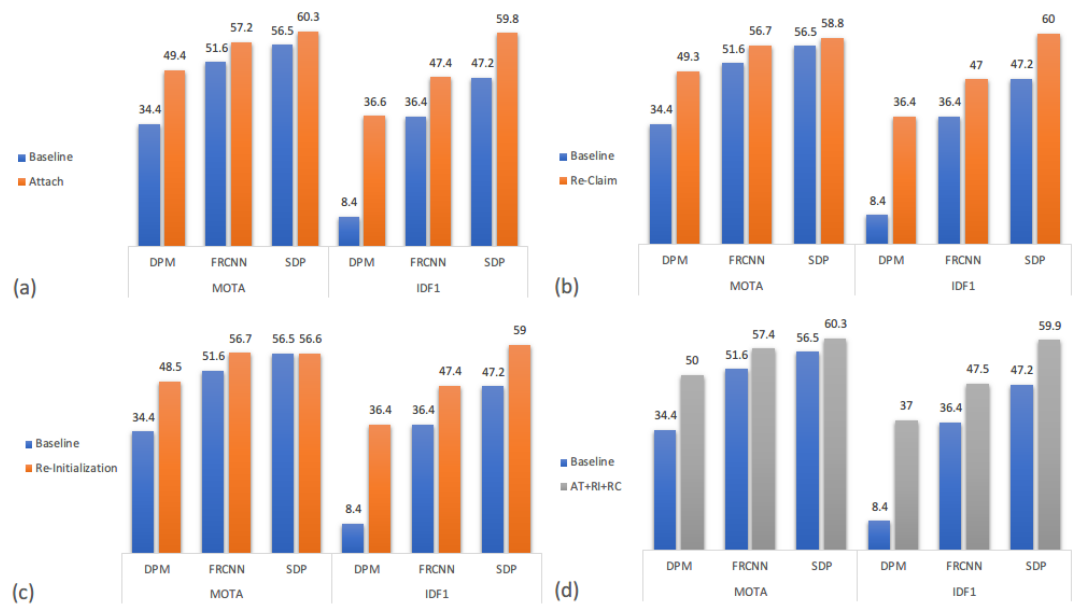
Figure 8. ( a – d ) show the comparison between each block and baseline method in MOTA and IDF1 score respectively.